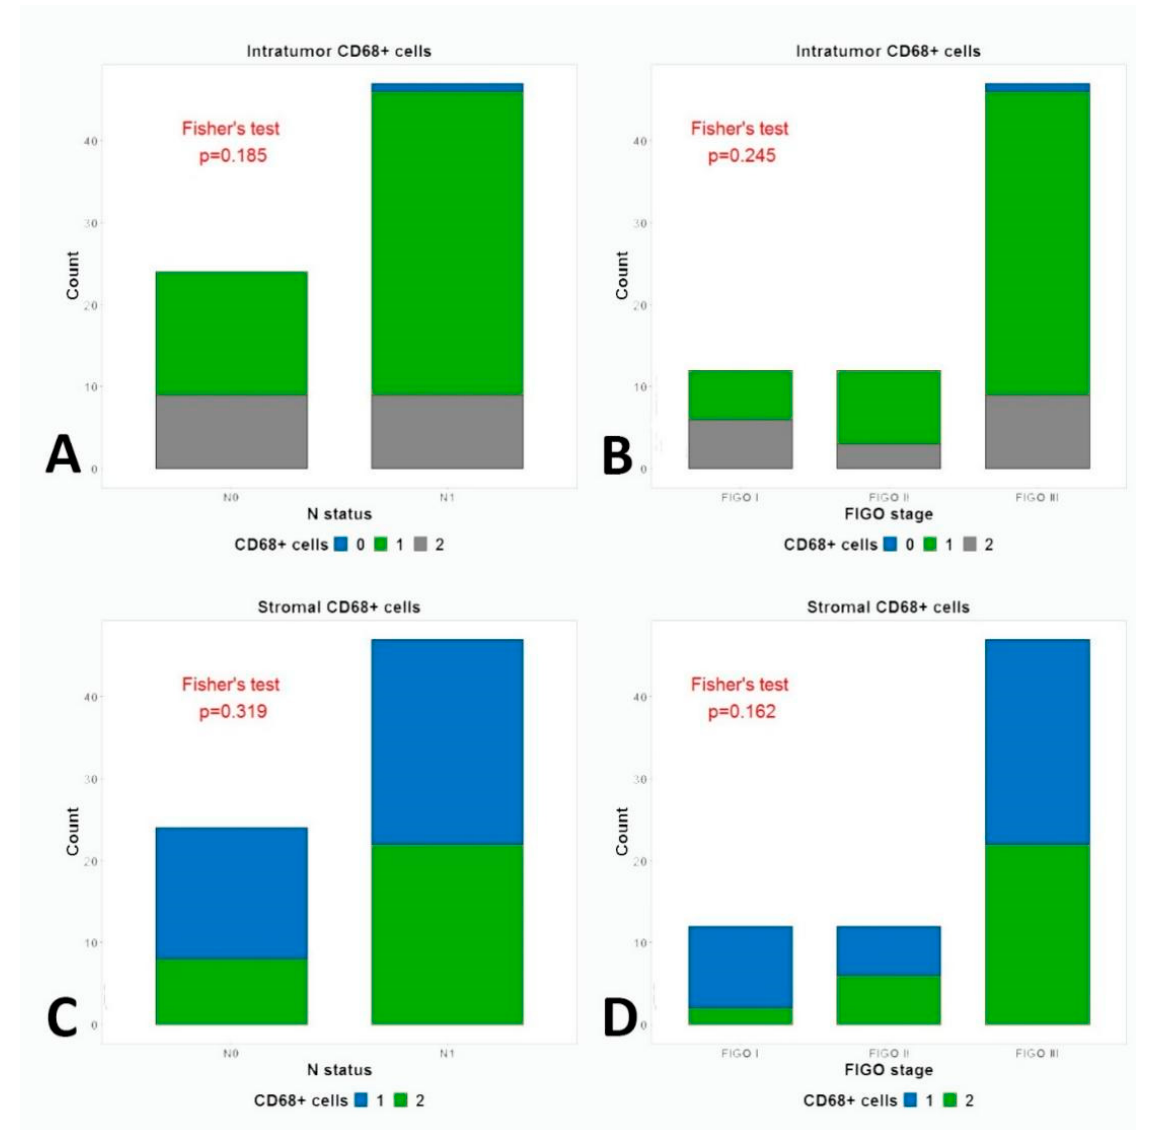
Figure 6. Fisher’s test for the association between ( A ) intratumor CD68 expression and N status; ( B ) intratumor CD68 expression and FIGO stage; ( C ) Stromal CD68 expression and N status; ( D ) stromal CD68 expression and FIGO stage.